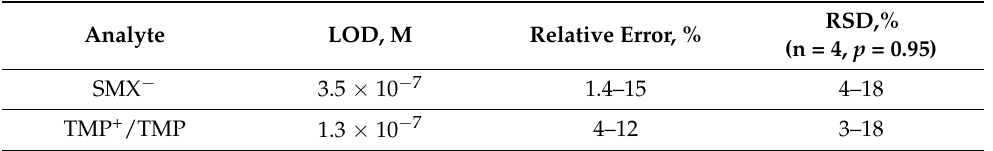
Table 3. The characteristics of the SMX − and TMP + /TMP determination in the model solutions ( c = 1.0 × 10 − 5 –1.0 × 10 − 3 M, pH 4.53–8.31) using the array of DP-sensors based on MF-4SC/1.0